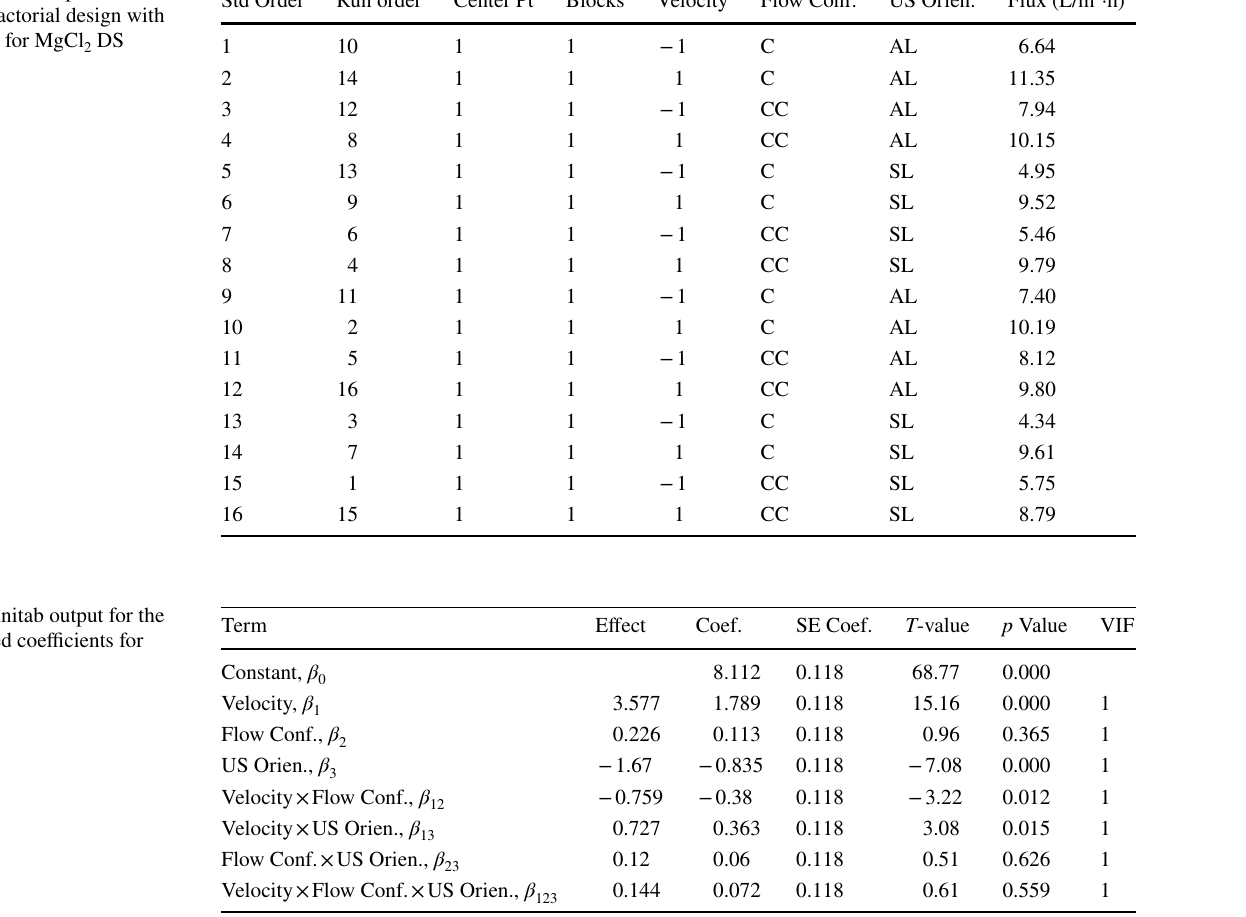
Table 6 Minitab input matrix for 2 3 full factorial design with 2 replicates for MgCl 2 DS